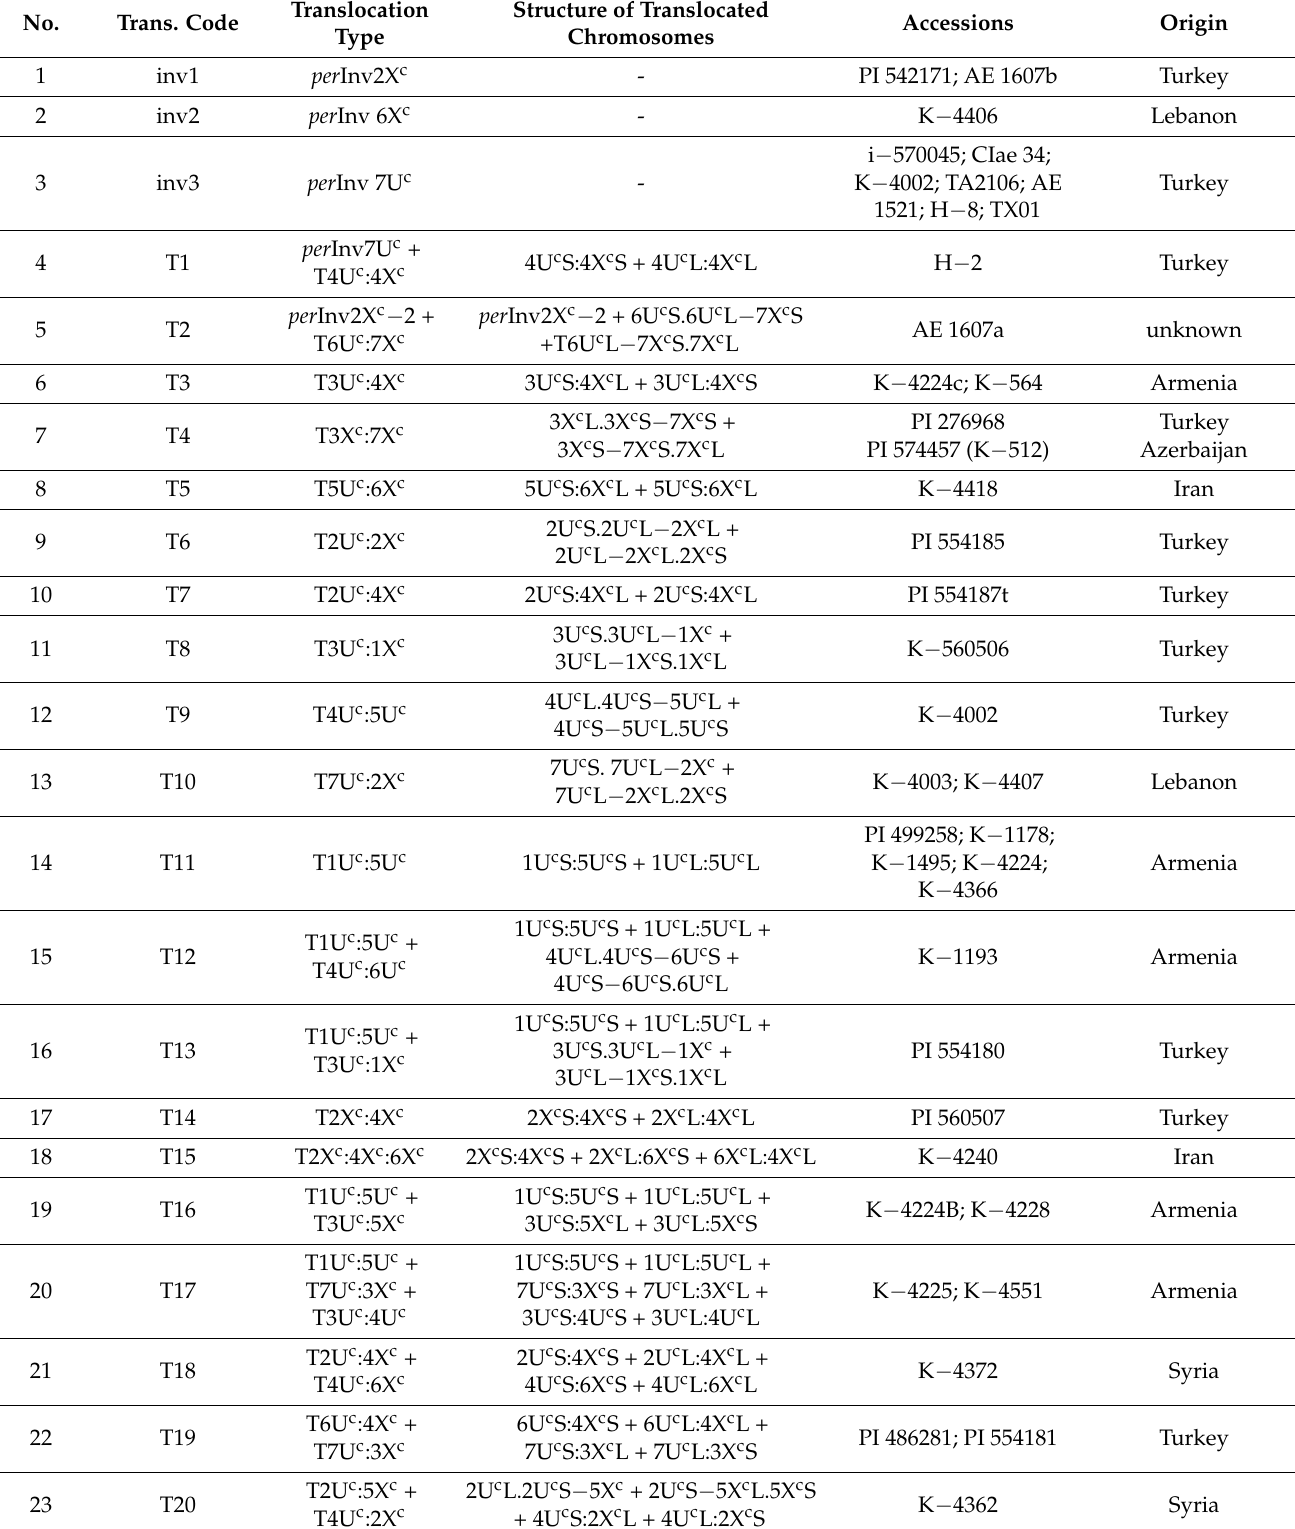
Table 2. Variants of chromosomal rearrangements identified in Ae. columnaris , type I accessions.